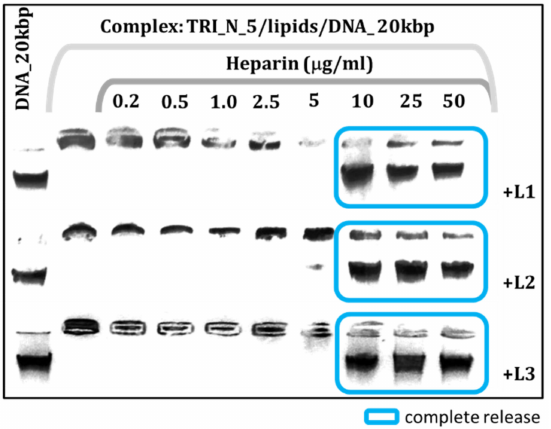
Figure 4. Agarose gel electrophoresis results obtained for lipoplexes based on TRI_N/lipids/DNA_20kbp with increasing heparin